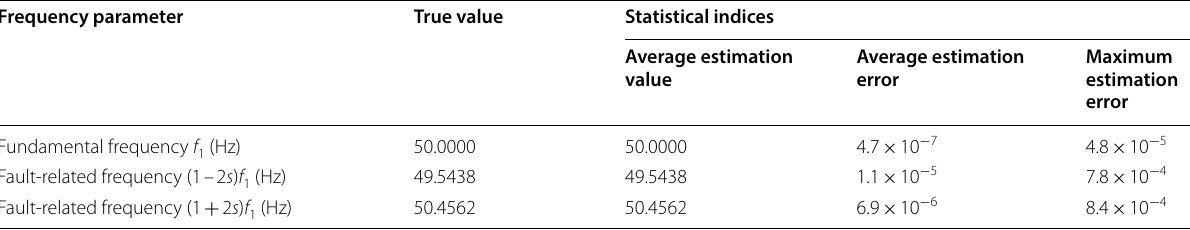
Table 3 Estimation results of IBPSO‑based MUSIC